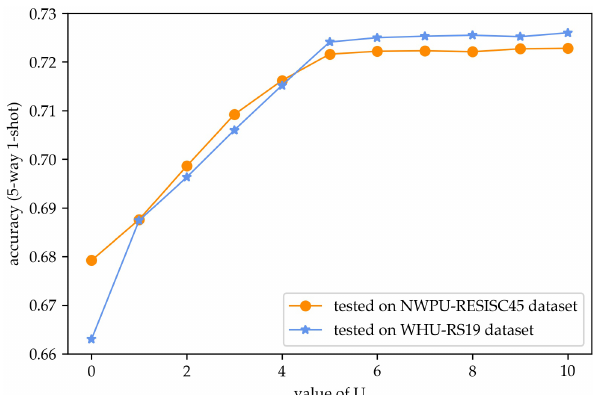
Figure 9. Accuracies with different prototype calibration strategies, where U is the number of selected images from the query